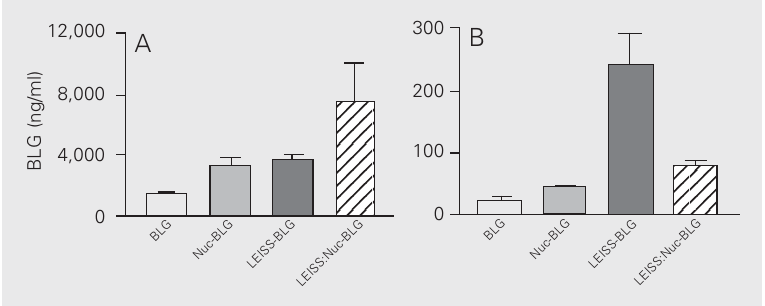
Figure 3. Production of BLG, LEISS-BLG, Nuc-BLG, and LEISS-Nuc-BLG in Lactococcus lactis was detected using two-site EIA specific for BLGn or BLGd in supernatant and cell lysate fractions from induced cultures. Data are reported as ng of BLG (BLGn + BLGd) per ml of induced culture. A , Total production: sum of BLG (BLGn + BLGd) detected in supernatant and cell lysate fractions. B , Sum of BLG (BLGn + BLGd) detected in superna- tant. BLG = bovine ß-lactoglobulin; Nuc = staphylococcal nuclease; LEISS = synthetic